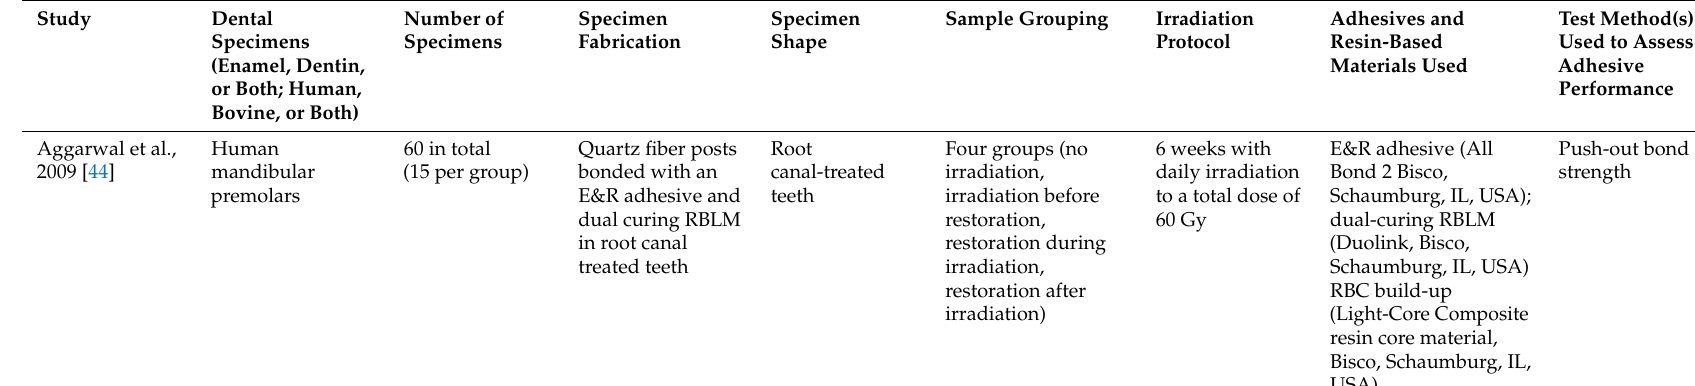
Table A1. Overview of the main characteristics of laboratory studies included in the systematic